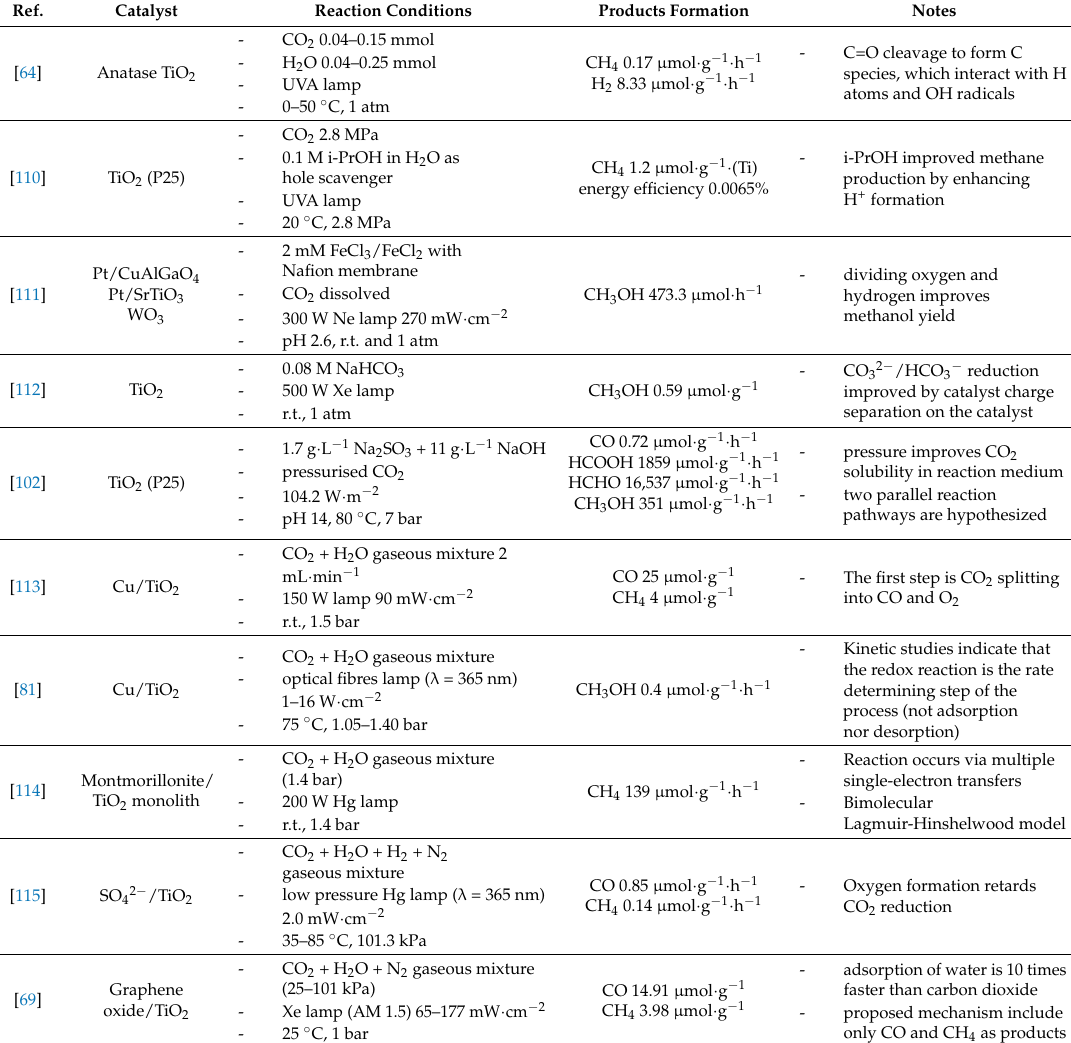
Table 2. Summary of proposed mechanisms found in the literature. Ref.